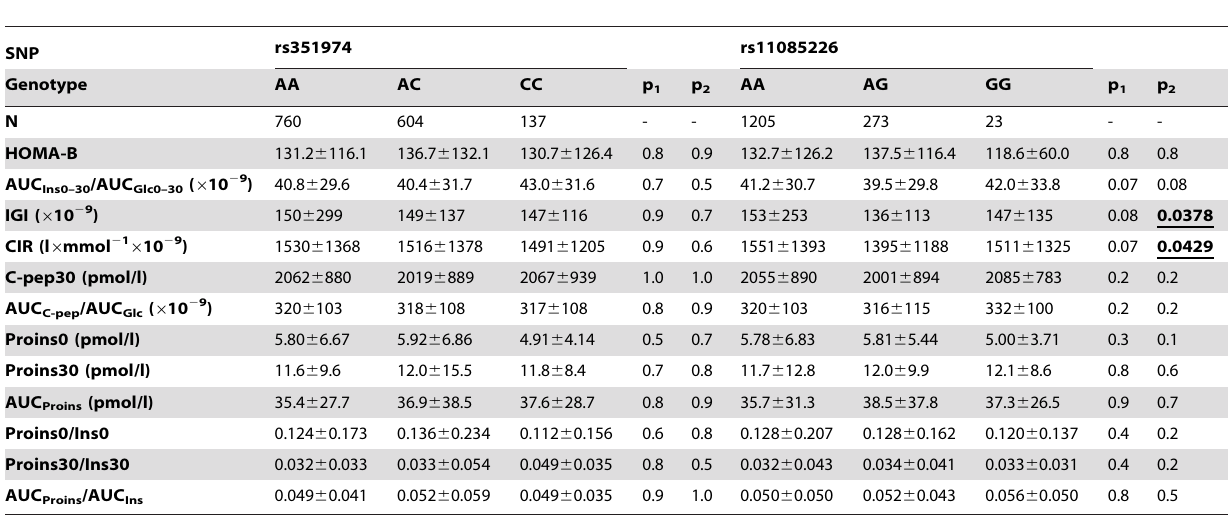
Table 3. Associations of PTBP1 SNPs rs351974 and rs11085226 with insulin secretion and proinsulin conversion in non-diabetic subjects (N =1502).